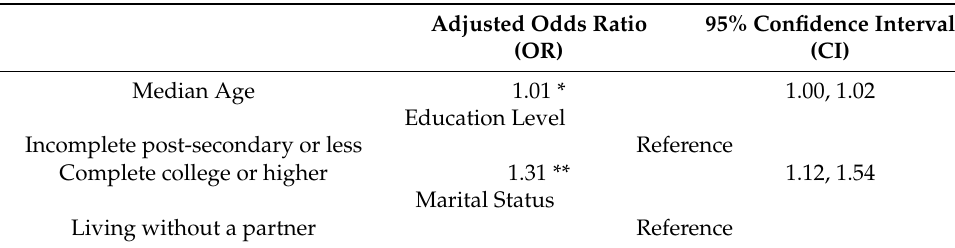
Table 2. Multivariable analysis of correlates of participants’ willingness to self-collect a vaginal sample for HPV-based cervix